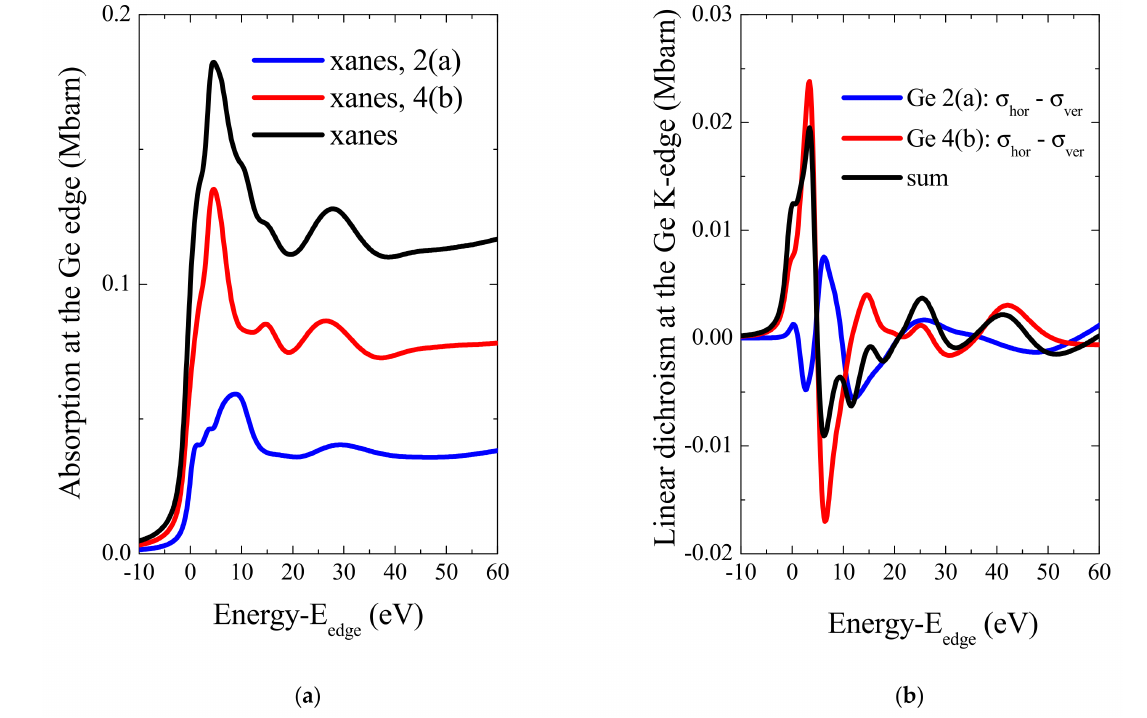
Figure 4. ( a ) Calculated X-ray absorption spectra of Ge atoms in positions 2(a) (blue line), 4(b) (red line) and their sum (black line); ( b ) Linear dichroism spectra corresponding to two nonequivalent Wyckoff positions of Ge atoms. Blue line-linear dichroism corresponding to Ge atoms at position 2(a), red line-Ge at position 4(b), black line-their sum. E edge = 11,113.8 eV.